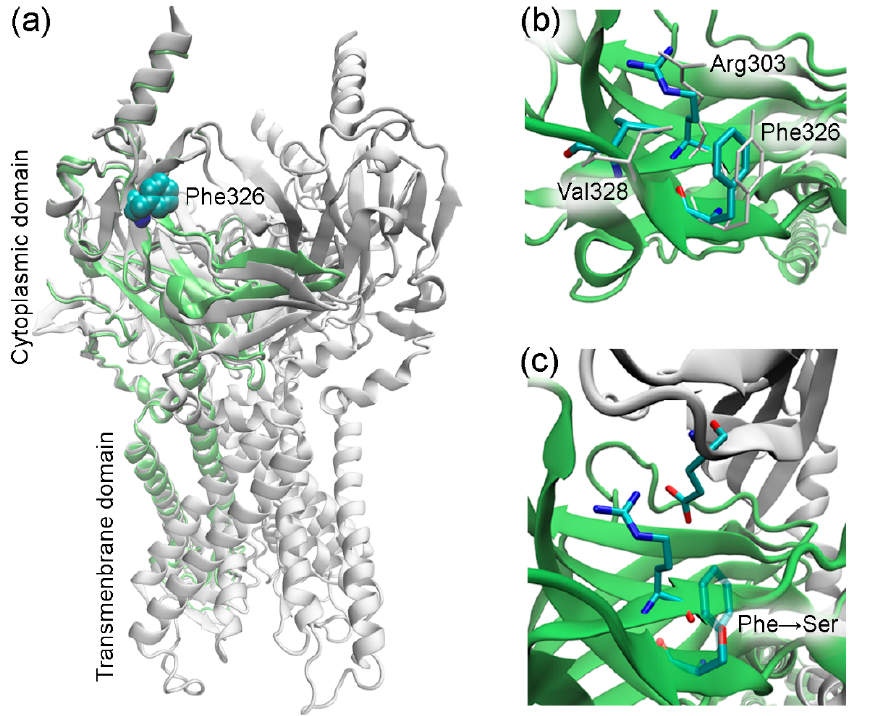
Figure 3. Multiple sequence alignment of human GIRK3 and its close homologs (UniProt entries P48051, Q92806, P63252, and Q14500). Residues 219, 303, 326, and 328 (GIRK3 numbering) are marked with asterisks. 4. Discussion GIRK G-protein-coupled potassium channels of internal rectification, which have an inhibitory effect on neurons, dysregulate the activity of these channels and, thus, contrib- ute to the development of various neurological diseases and disorders [30]. GIRK1-4 pro- teins are encoded by the KCNJ3 (GIRK1), KCNJ6 (GIRK2), KCNJ9 (GIRK3), and KCNJ5 (GIRK4) genes and are homologous subunits (also conserved across species, such as hu- mans and mice, which is helpful for creation of mouse models), each of which has features of regulation and tissue and subcellular distribution [31], so that by composing various homo- or heterotetramers, these proteins can form channels with different properties and localization [32].